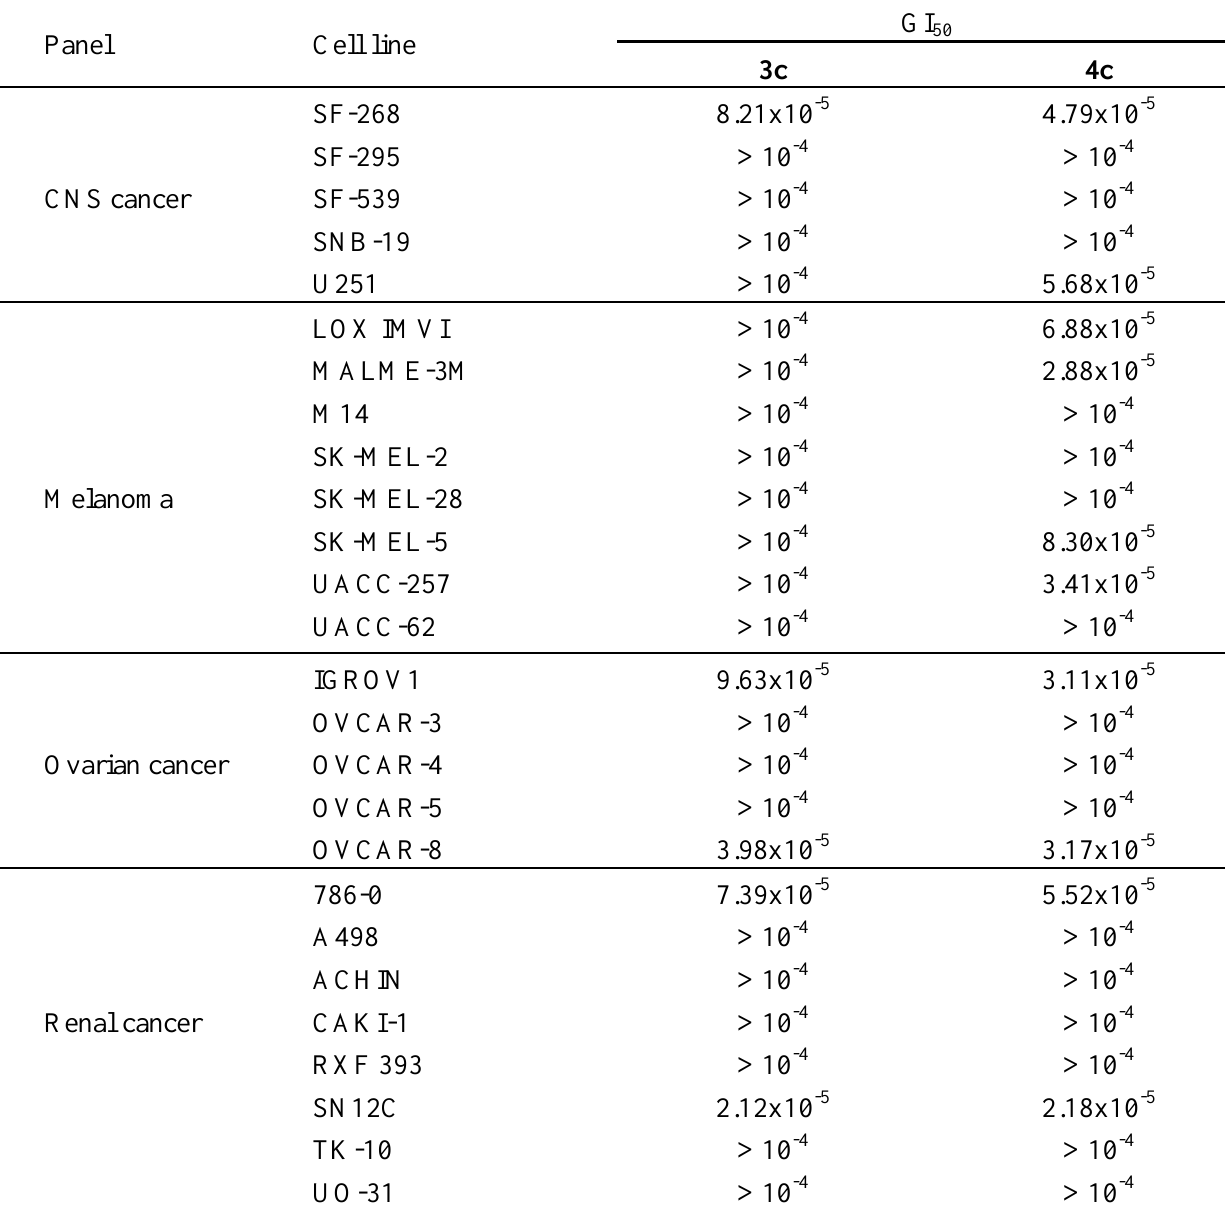
Table 3 . Comparative in vitro anti-tumour activity of diastereoisomers 3c and 4c against CNS, melanoma, ovarian and renal cancer cell